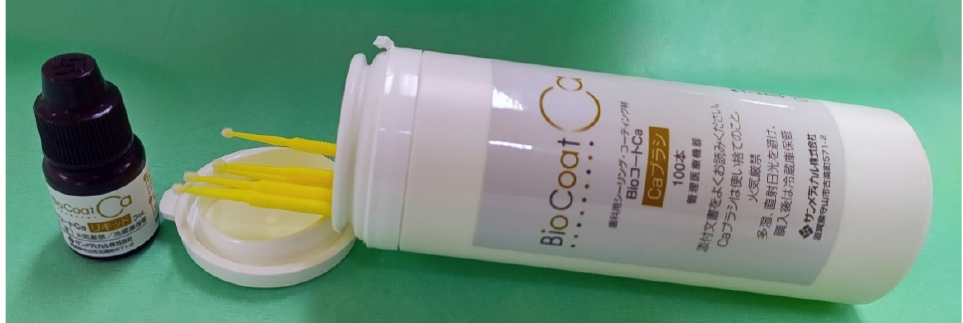
Figure 2. BioCoat Ca is approved as a hypersensitivity inhibitor and self-etch adhesive with Bioactive Monomer™ added to Hybrid Coat (Sun Medical). Bioactive Monomer™ consists of a liquid with 4-methacryloxyethyl trimellitic anhydride (4-META), a brush with a polymerization initiator,